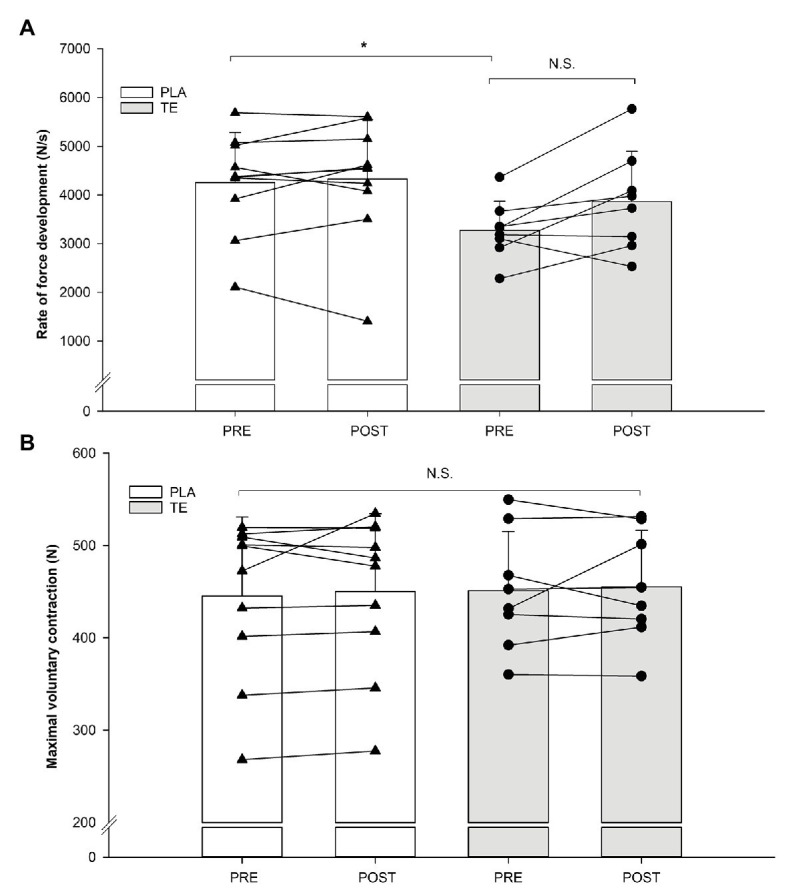
Individual values of rate of force development (A) and maximal voluntary contraction (B) in a one-arm isometric elbow flexion before (pre) and after (post) placebo (PLA; n = 10) administration (white) and testosterone ester (TE; n = 8) administration (gray). Histograms indicate means with error bars indicating one standard deviation of the mean. *Significant (p < 0.05) main effect of treatment. NS, not significant.